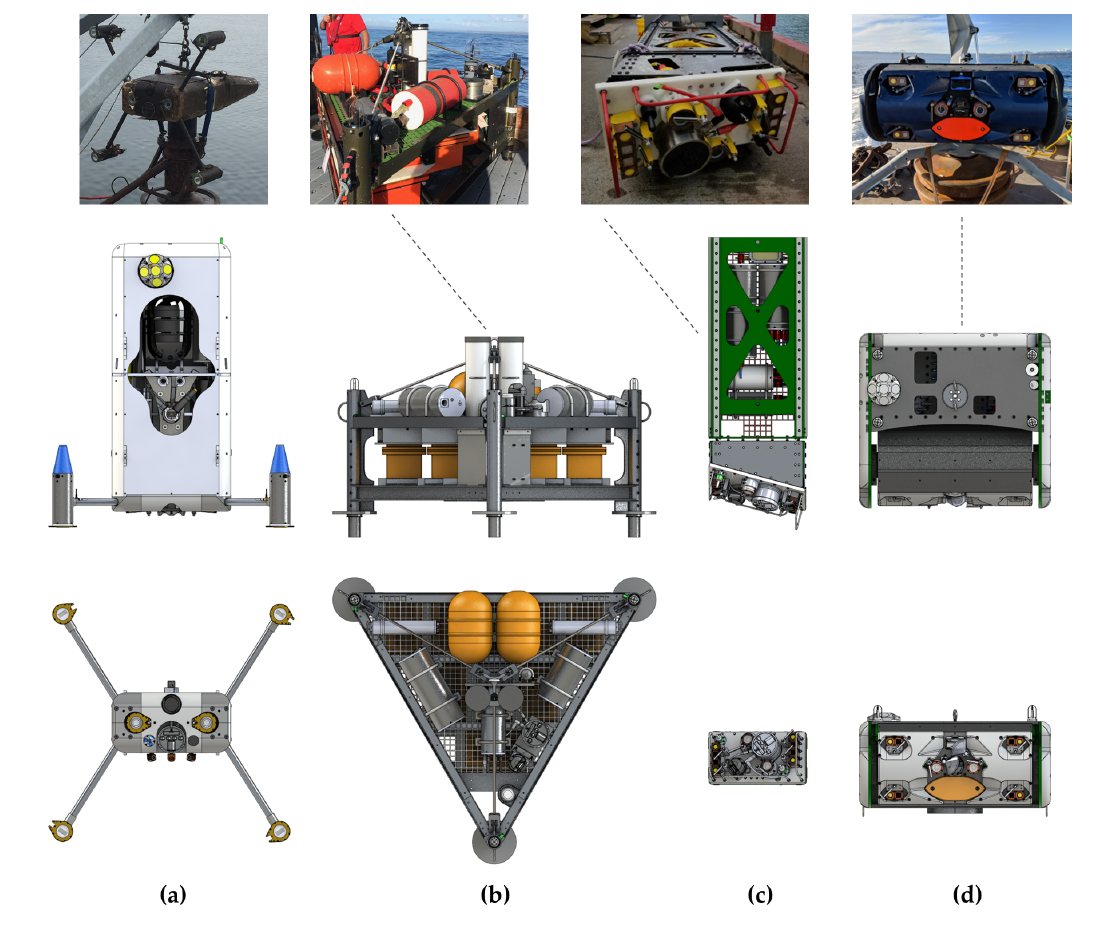
Figure 3. AMP configurations from select deployments: ( a ) MSL-1, ( b ) AutoAMP, ( c ) WAMP, and ( d ) MSL-2. Top row: Photographs of AMP configurations. Middle row: constant-scale profile view of instrumentation and core platform elements (excludes mounting structures). Bottom row: constant-scale view of primary sensor